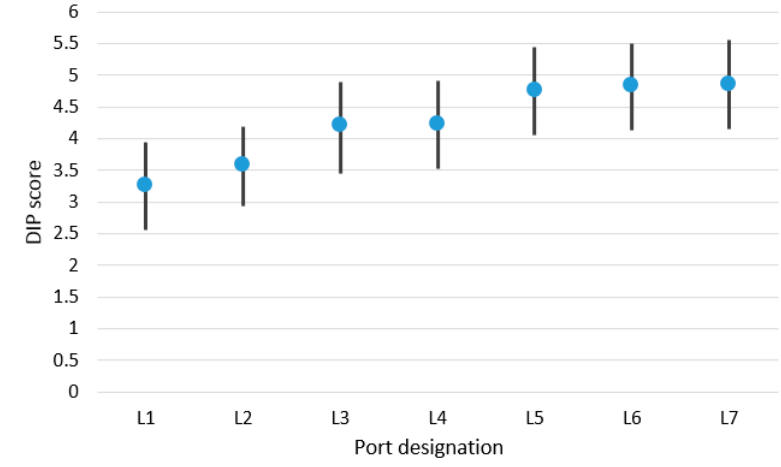
Figure 6. Large ports DIP score and DIP scoring band.